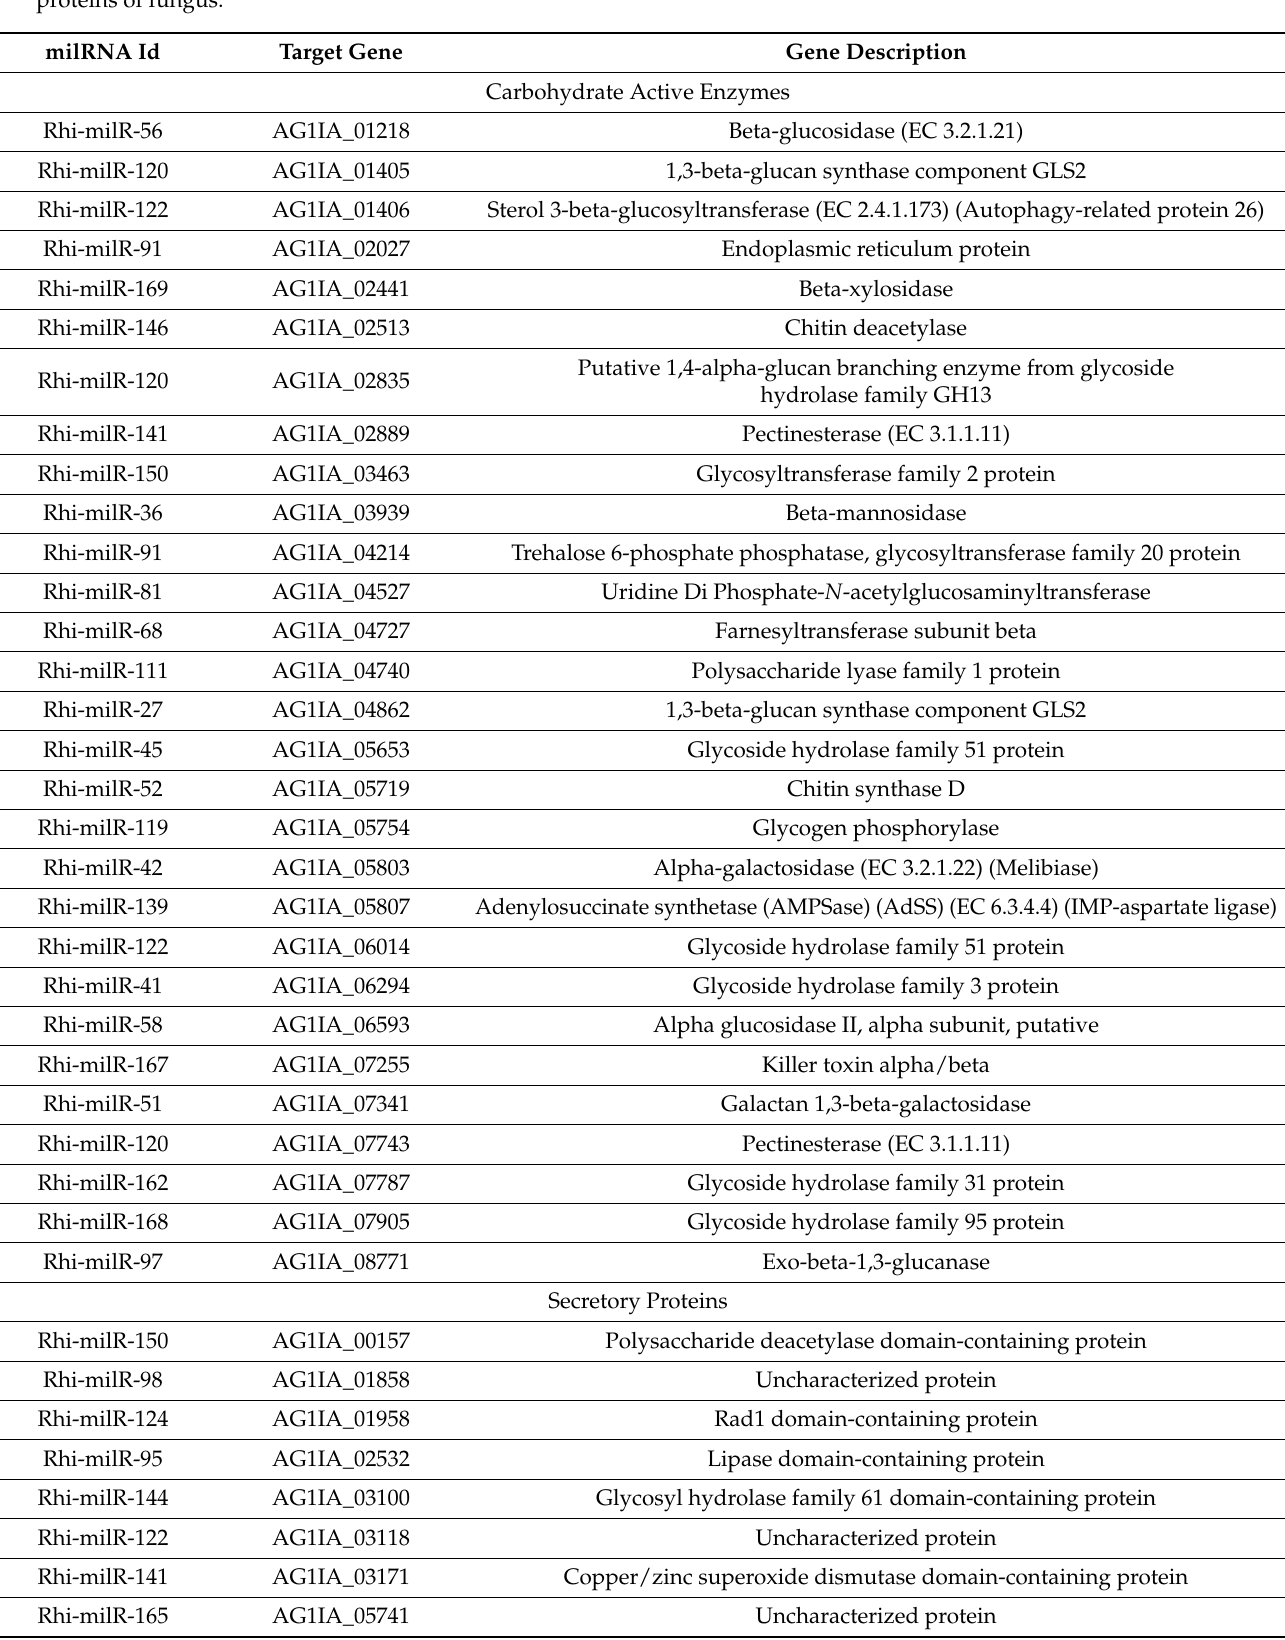
Table 2. Gene targets of Rhizoctonia solani -milRNAs. These target genes encode carbohydrate active enzymes and secretory proteins of